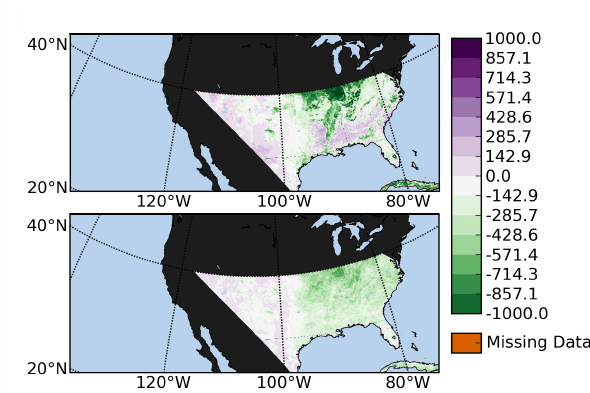
Fig. 15. The 2004 VPRM June-July-August integrated NEE. Top panel shows all-sites–all-data parameters, bottom panel shows PFT– all-data parameters. Units are gCm − 2 yr − 1 . Black areas were not calculated for this